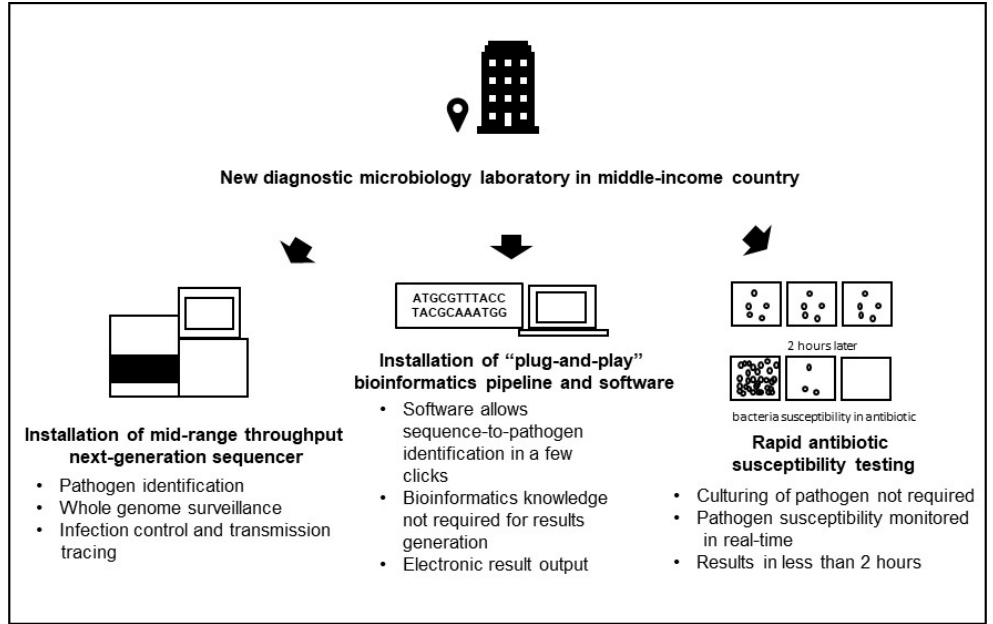
Figure 2. Considerations for new diagnostic microbiology laboratories in middle-income countries utilizing 16SNGS as the main platform for bacterial pathogen detection.